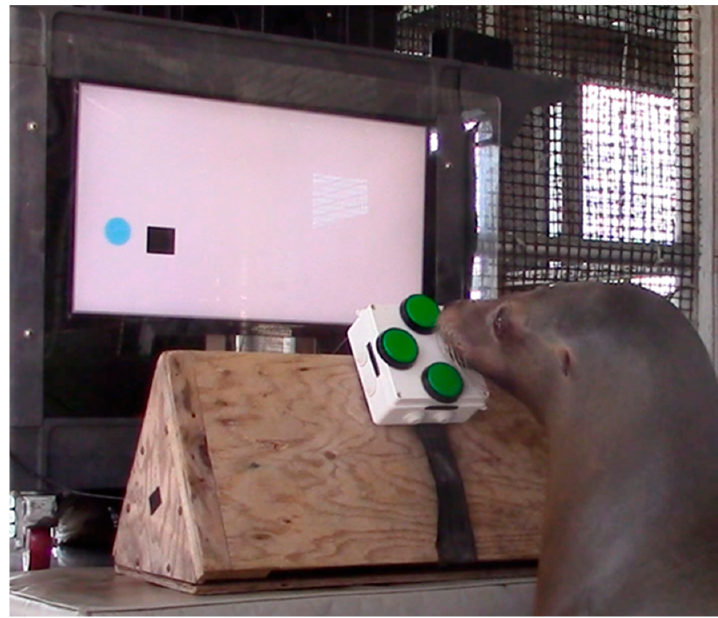
Figure 2. Example of a CTG Phase 6 Trial.